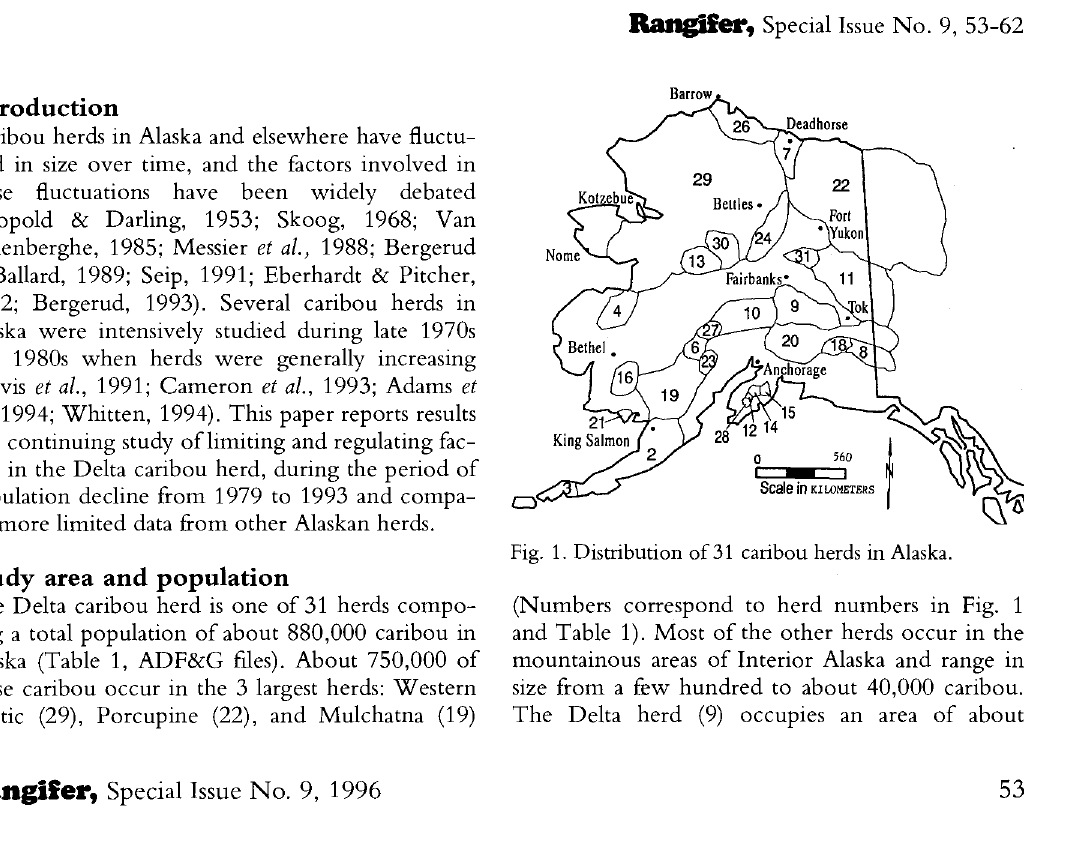
Fig. 1. Distribution of 31 caribou herds in